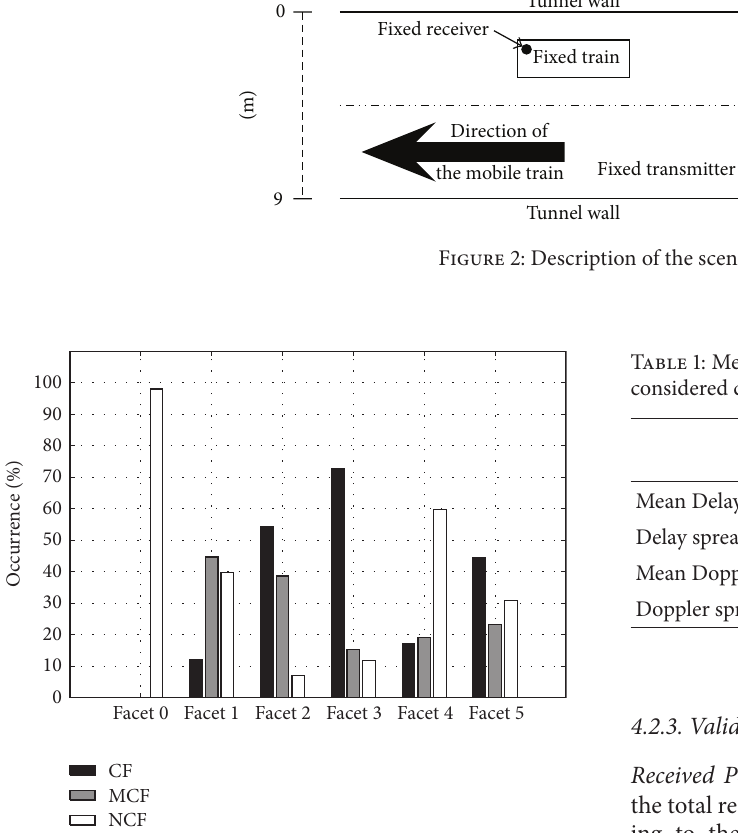
Figure 3: Identification of contribution degree of the facets along the mobile train route.